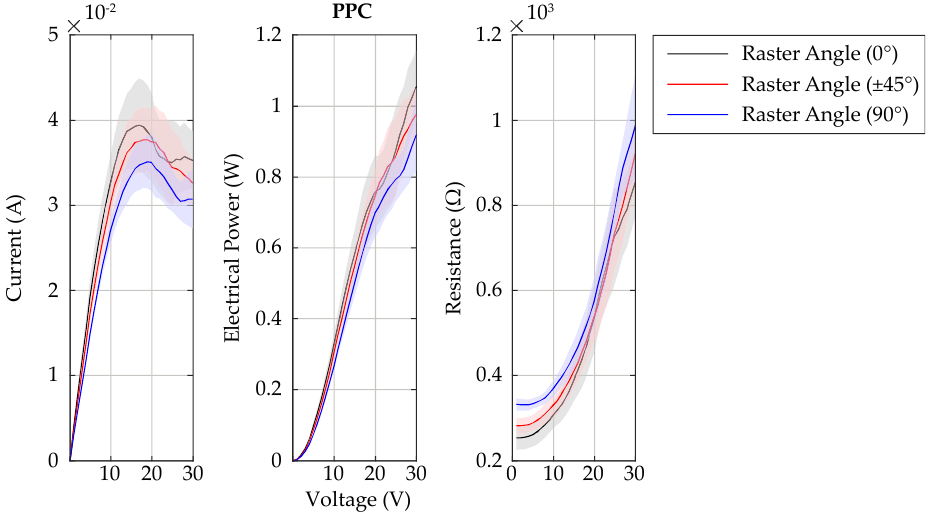
Figure 17. Representation of current, electrical power and resistance depending on voltage of PPC.